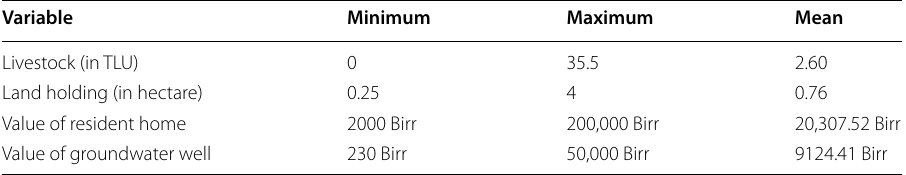
Table 4 Summary of wealth proxy variables. Source: Own Survey, 2015